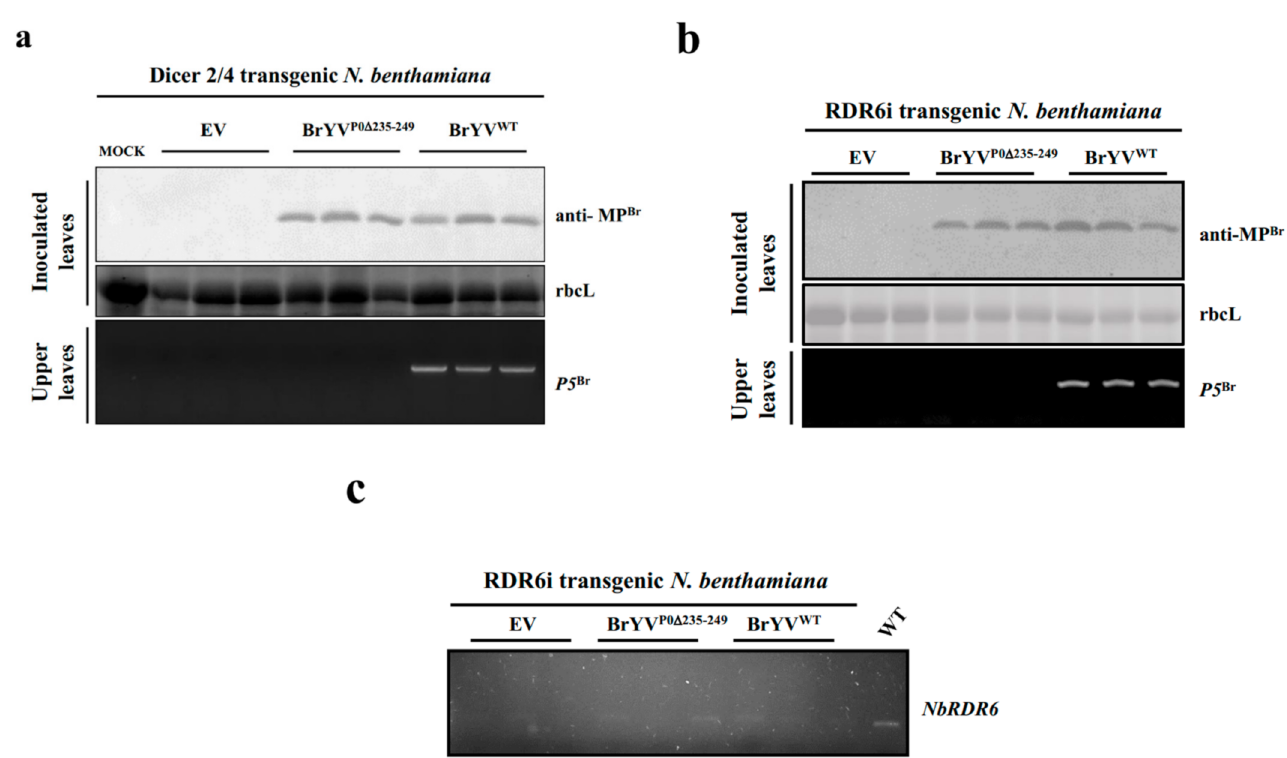
Figure 6. DCL2/4i and RDR6i transgenic plants were not systemically infected by the BrYV mutant BrYV P0 ∆ 235 − 249 . ( a , b ) Protein determinations from virus-inoculated DCL2/4i and RDR6i transgenic N. benthamiana leaves at 2 dpi as assessed by Western blotting analysis using a BrYV-MP-specific antibody (anti-MP Br ). RNA determinations from the upper leaves of RDR6i transgenic N. benthamiana plants at 14 dpi as assessed by RT-PCR using P5 Br -specific primers. ( c ) Confirmation of RDR6i trans- genic plants by RT-PCR using NbRDR6-specific primers. WT: non-transgenic N. benthamiana